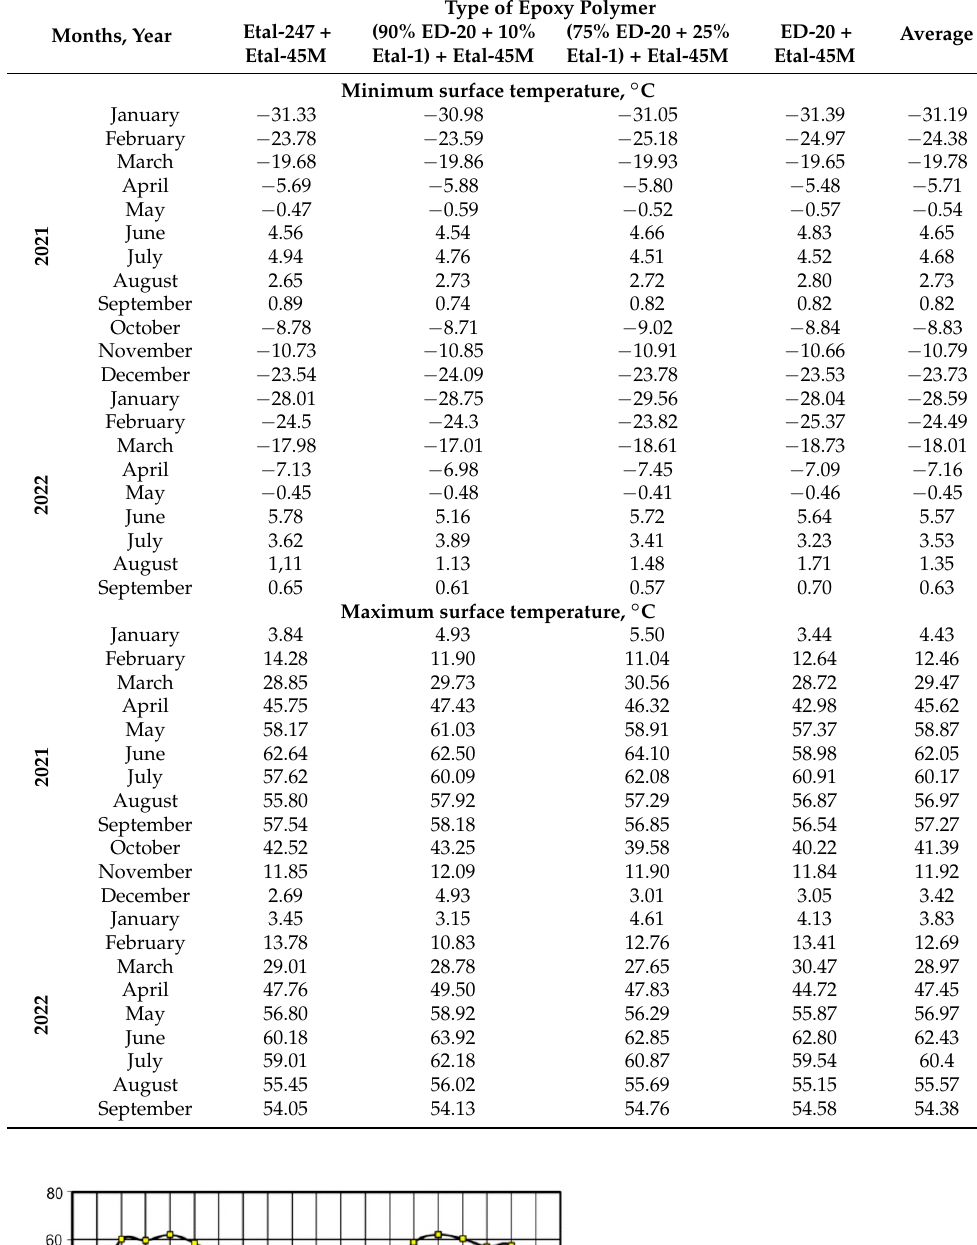
Table 6. The minimum and maximum values of the surface temperatures of the samples of the studied compositions, depending on the month of the study.